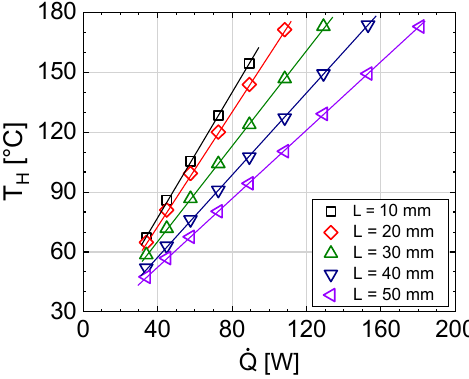
Figure 8. Plot of heater temperature T H vs. heating power ´ Q for condenser plate widths of 10–50 mm for reference copper plate. Lines are given as eye guides.